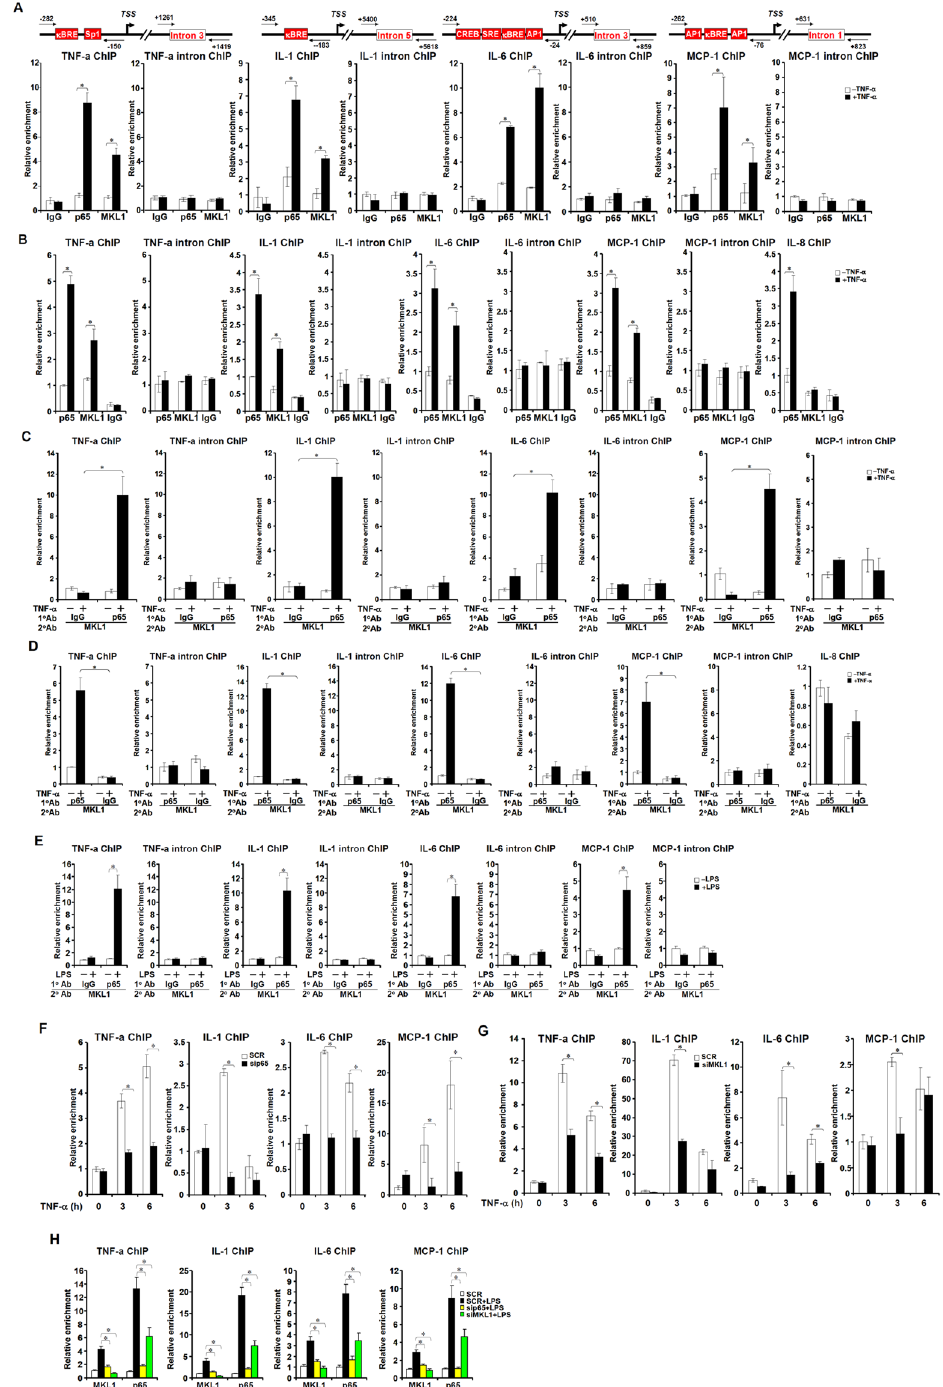
Figure 3. A reciprocal interplay between MKL1 and p65 on the chromatin. ( A , B ) THP-1 cells ( A ) or differentiated primary human macrophages ( B ) were treated with TNF- α (10 ng/ml) for 6 hours. ChIP assays were performed with indicated antibodies. Precipitated DNA was amplified with indicated primers shown with conserved binding motifs. κ BRE, NF- κ B response element; SRE, serum response element; TSS, transcription start site ( C , D ) THP-1 cells ( C ) and differentiated primary human macrophages ( D ) were treated with or without TNF- α (10 ng/ml) for 3 hours. Re-ChIP assays were performed with indicated antibodies. ( E ) THP-1 cells were treated with or without LPS (100 ng/ml) for 6 hours. Re-ChIP assays were performed with indicated antibodies. ( E , F ) THP-1 cells were transfected with indicated siRNA followed by treatment with TNF- α (10 ng/ml) for 6 hours. ChIP assays were performed with anti-MKL1 ( E ) or anti-p65 ( F ). ( H ) THP-1 cells were transfected with indicated siRNA followed by treatment with LPS (100 ng/ml) for 6 hours. ChIP assays were performed with anti-MKL1 or